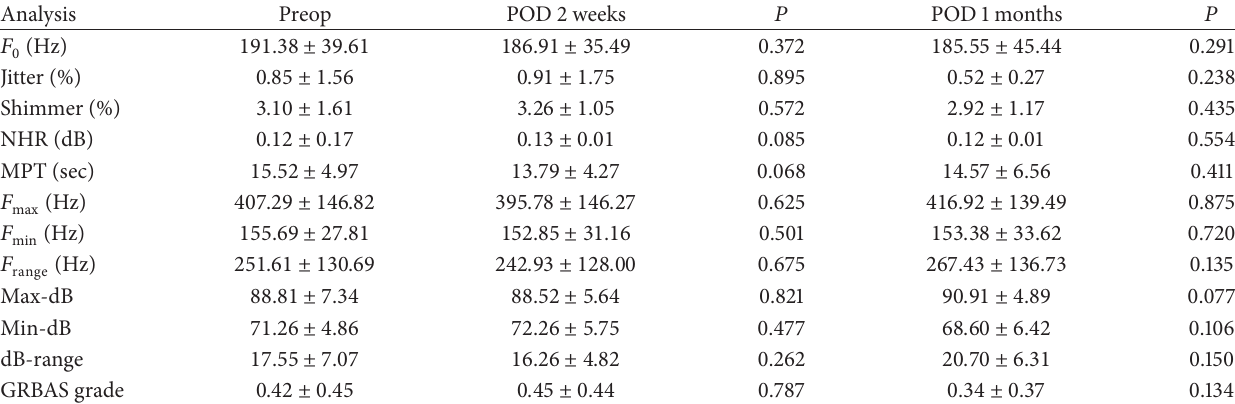
Table 3: Comparison of preoperative and postoperative outcomes of various vocal analysis in group B.